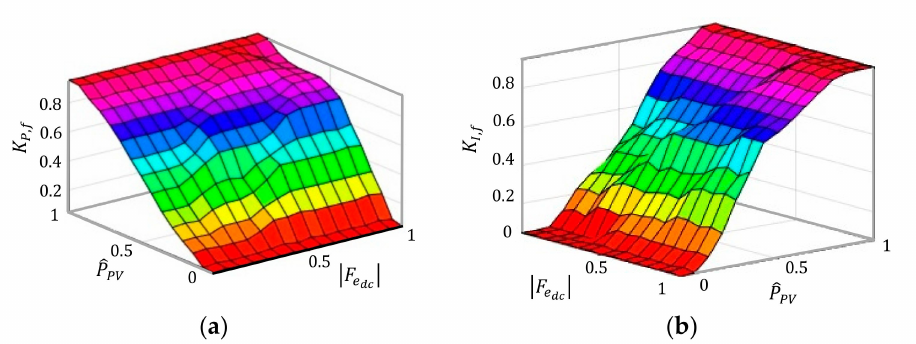
Figure 9. Response surfaces: ( a ) K P , f ( k ) , and ( b ) K I , f ( k ) .